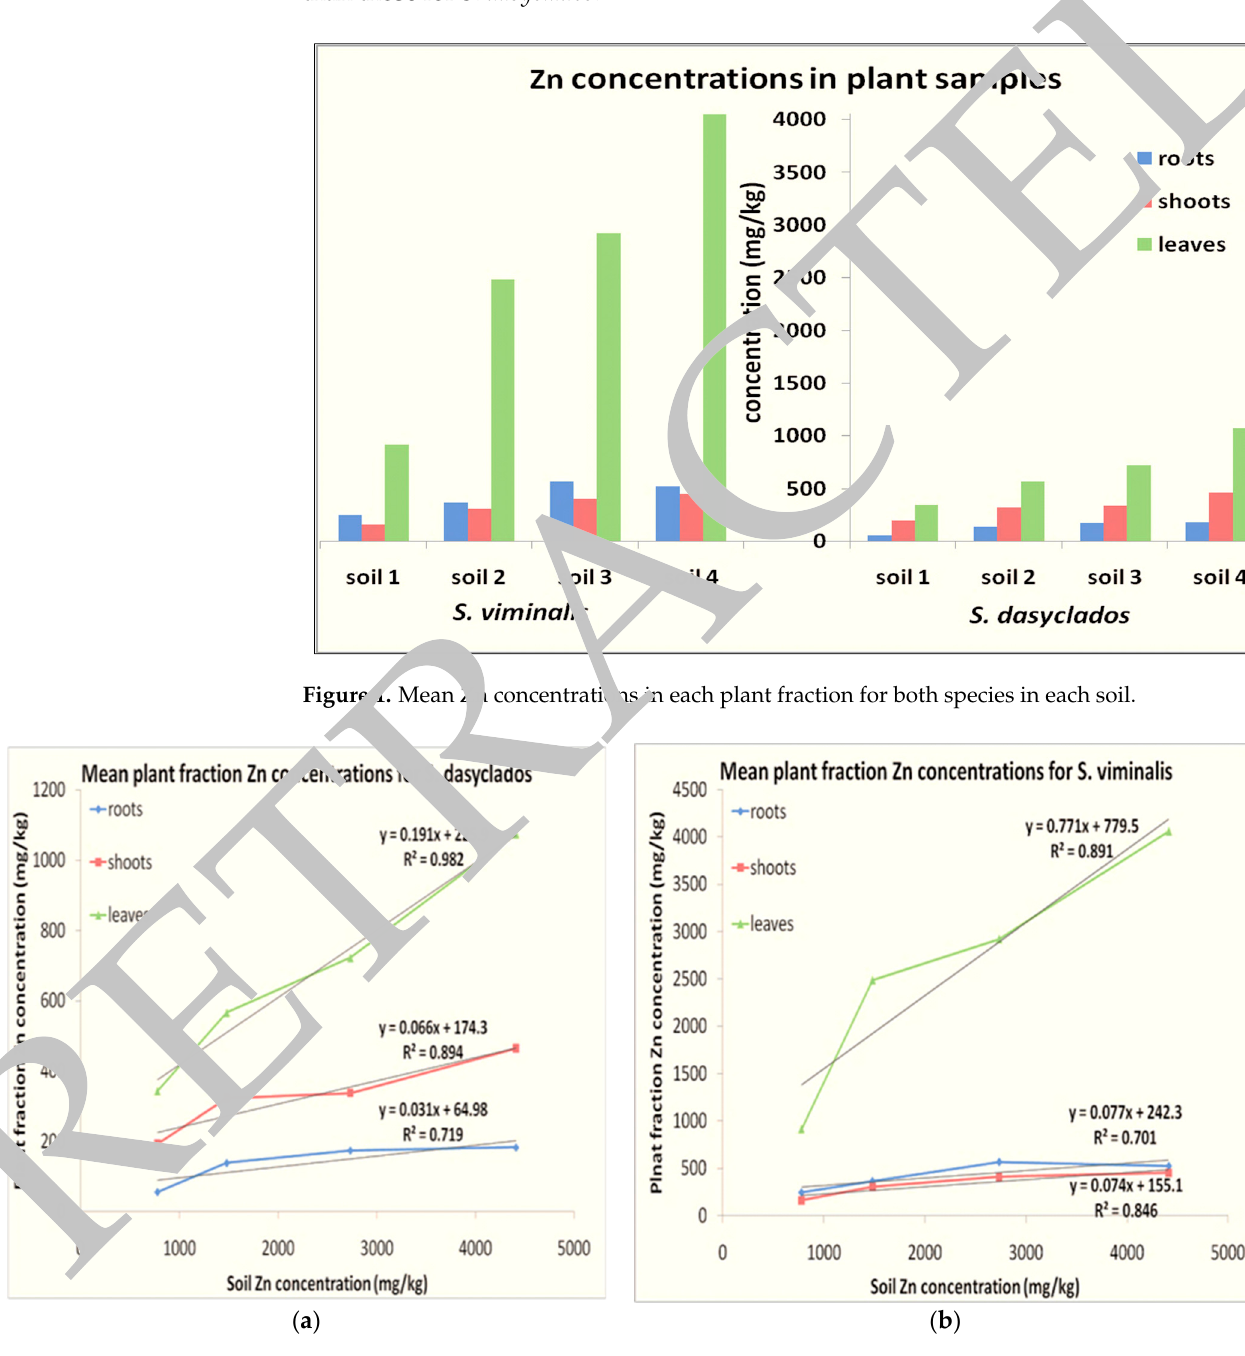
Figure 2. Mean plant fraction Zn concentrations as a function of soil contamination level showing trendline equations and R 2 values for S. dasyclados ( a ) and S. viminalis (b) .